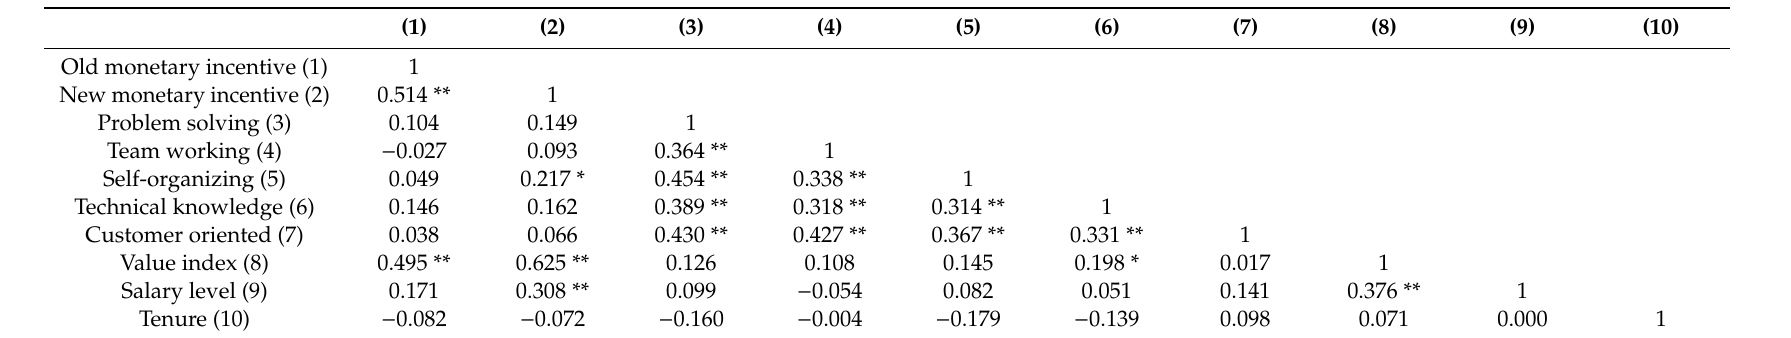
Table 3. Pearson correlations between predictors of the first